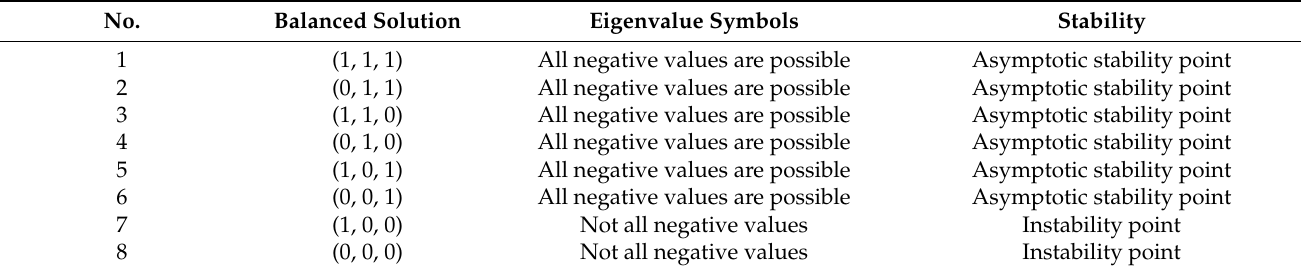
Table 4. Stability of the equilibrium